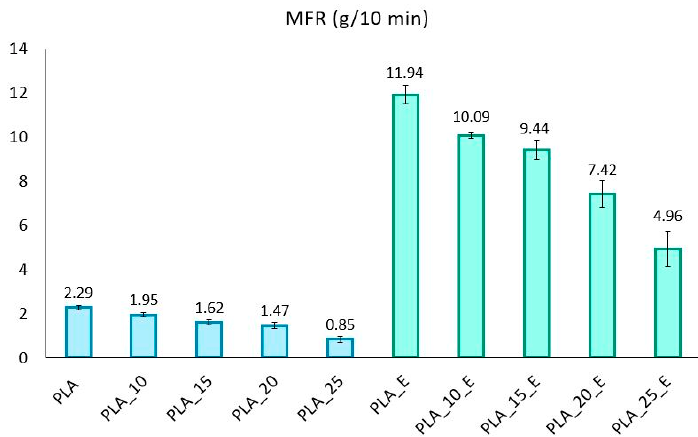
/ Arbocel composites with and without Figure 8. MFR values for PLA/Arbocel composites with and without Einar. Figure 8. MFR values for PLA